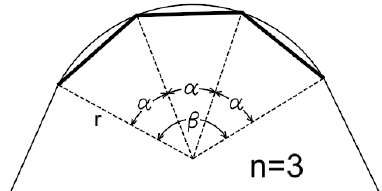
Figure 1. Classic approach to the approximation of circular arcs using chords, n = 3.